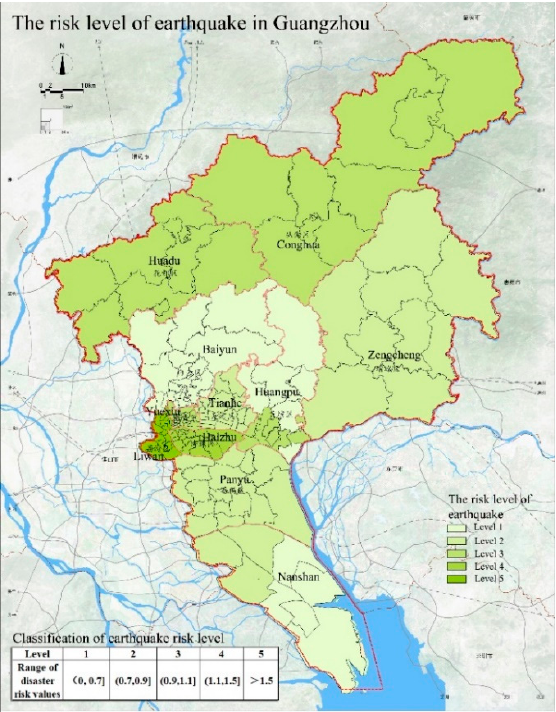
Figure 4. The risk levels of earthquake in Guangzhou.